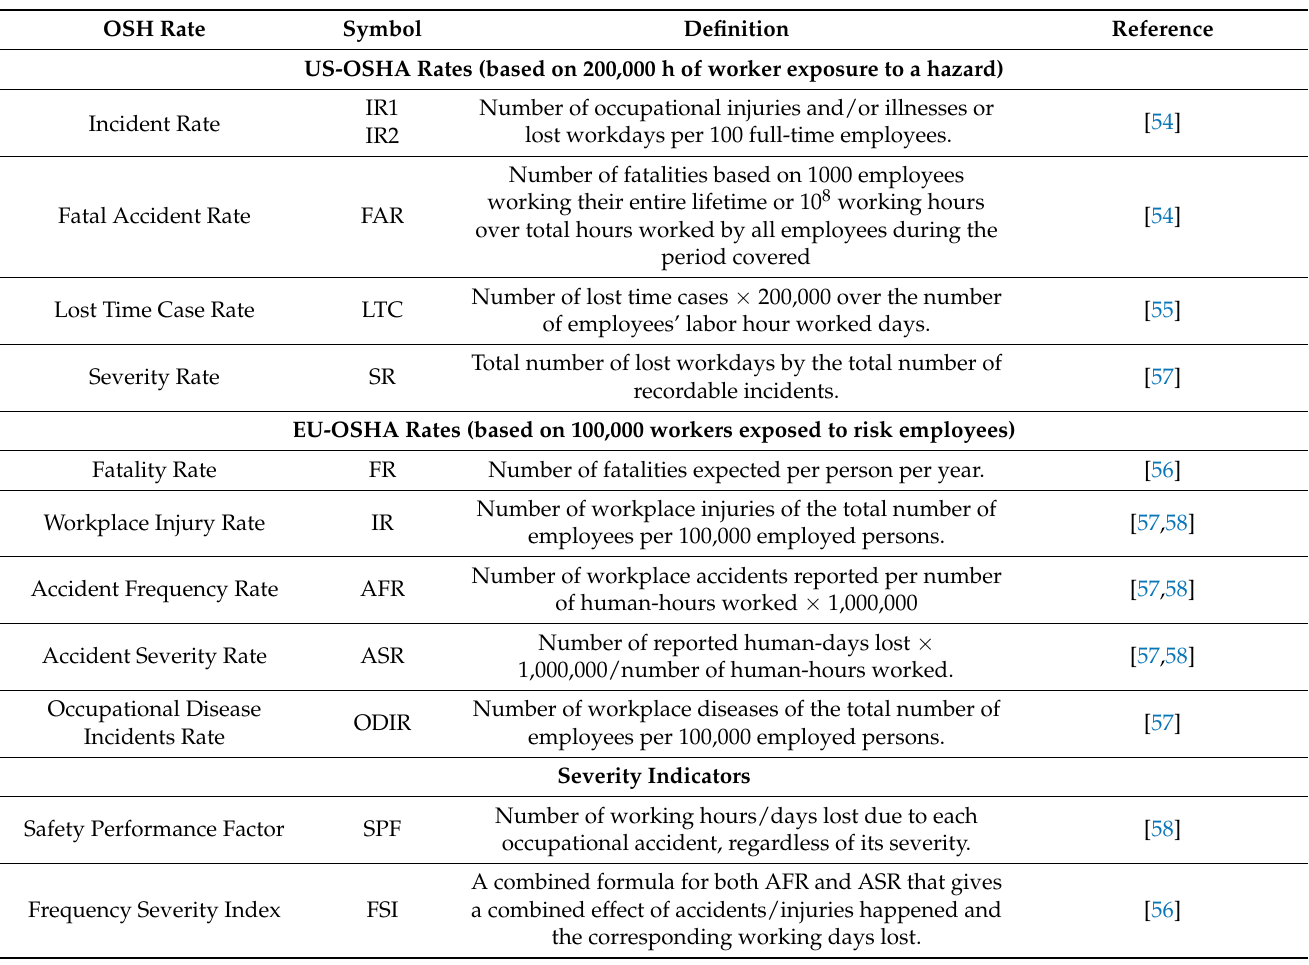
Table 2. The applied OSH rate formulas and their